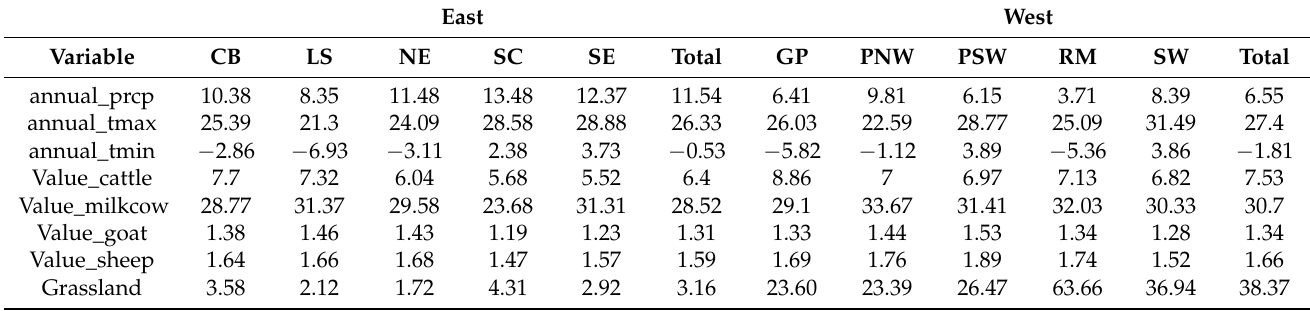
Table 5. Explanatory variables values by region.